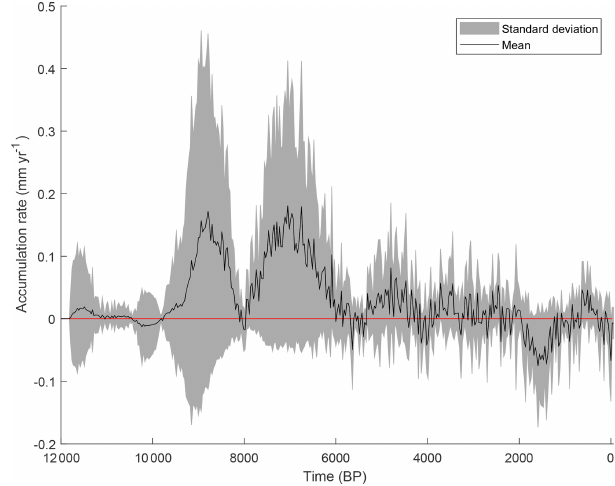
Figure 7. Modelled and measured mean peat thickness per topo- graphic class for both the calibration and validation transects.